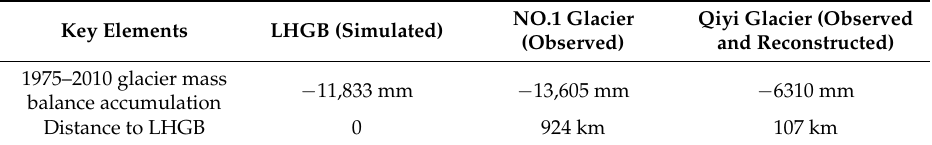
Figure 10. Simulated annual glacier mass balance (black curve) and cumulative glacier mass balance (blue curve) in LHGB from 1959 to2015. Table 4. Comparison of the accumulated mass balance between Laohugou glaciers simulated by the HBV model and the observed nearby glacier mass balance.